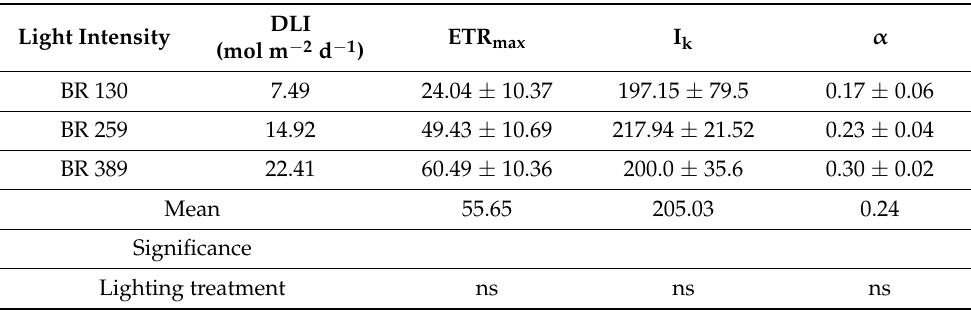
Figure 3. Chlorophyll a fluorescence light response curve. ( a ) Yield of Φ PSII and ( b ) yield of non-regulated quenching ( Φ NO ), ( c ) photochemical quenching ( qP ), and ( d ) non-photochemical quenching (NPQ) in Batavia lettuce cv ‘Blackhawk’ grown under three different light intensities (130, 259, 389 µmol m − 2 s − 1 ). Means value ± standard error ( n = 5, 30 DAT). Light intensity treatment did not influence significantly the ETR light response curves; the parameters ETR max , I k , and α were on average 45, 205, and 0.03 (Table 1). Table 1. ETR light response curve-fitting results, maximal electron transport rate (ETR max ), minimum saturating irradiance (I k ), and the slope of the curve ( α ) in lettuce type Batavia cv Blackhawk grown under three different light intensities (130, 259, 389 µmol m − 2 s − 1 ). Mean values ± standard errors ( n = 5, 30 DAT); ns indicates no statistical difference.